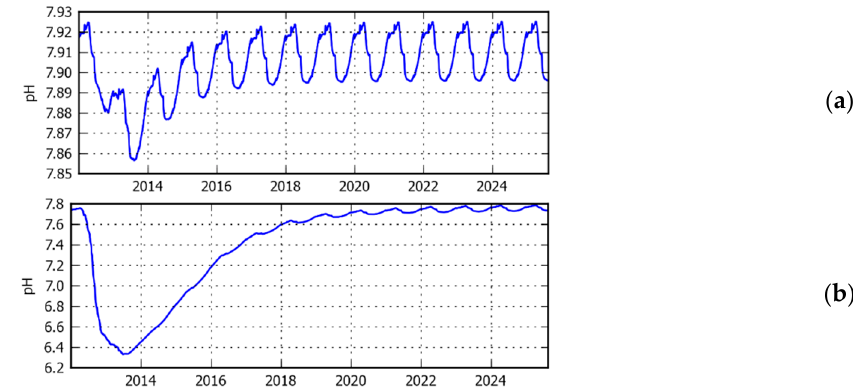
Figure 13. Variability of pH below the fish farm in 1 cm above the bottom ( a ) and at the SWI ( b ) before, during and after the farm installation.